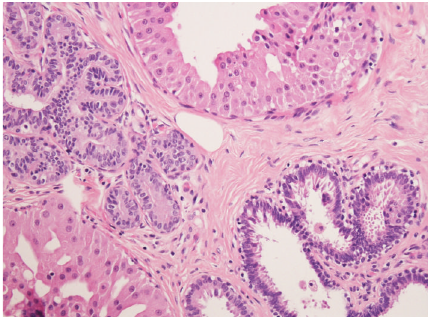
Figure 3: Areas of apocrine change, × 200.